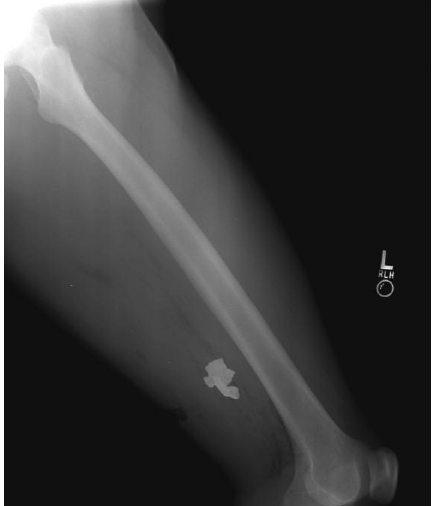
Figure 6. Case 3: Lateral radiographs of the left thigh and femur of a 24 year-old male service member demonstrating opacities representing retained metal and composite material fragments in the soft tissues of the posterolateral thigh due to an improvised explosive device